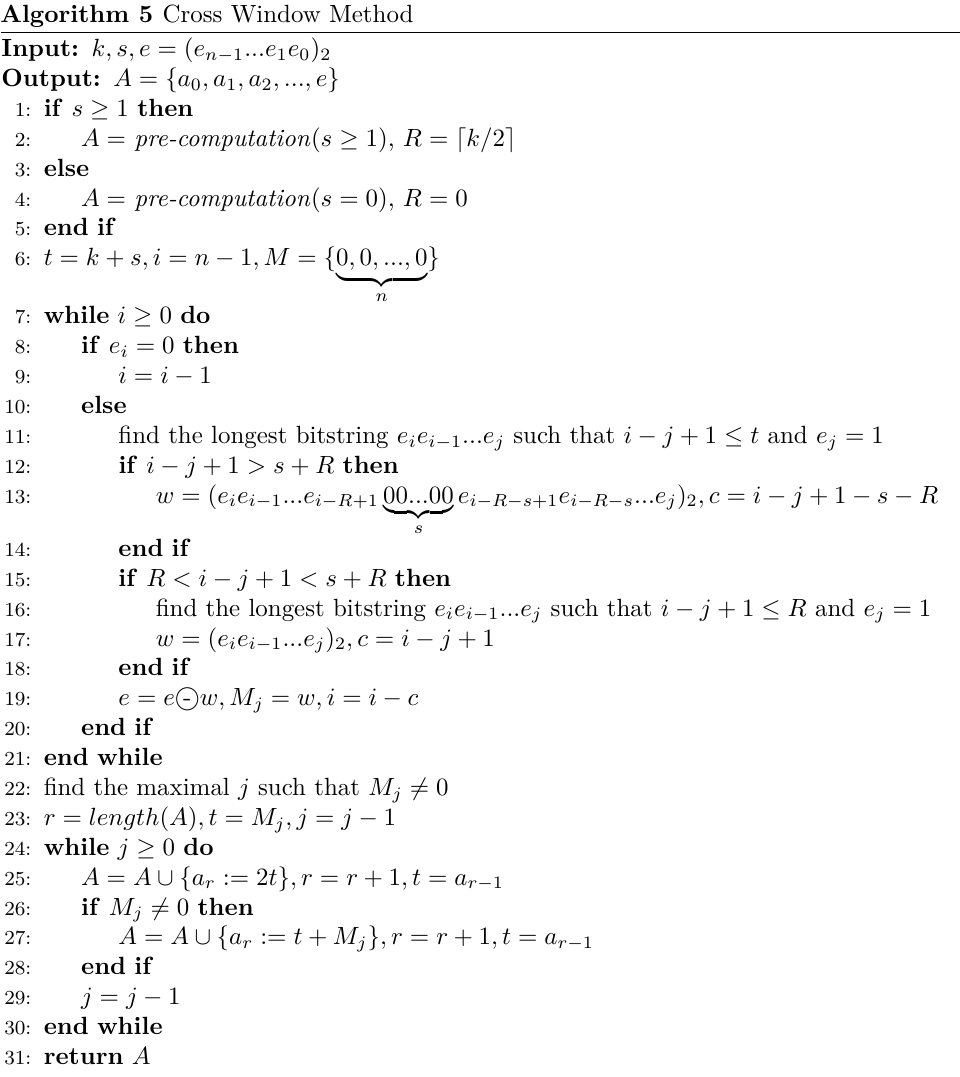
Algorithm 5 Cross Window